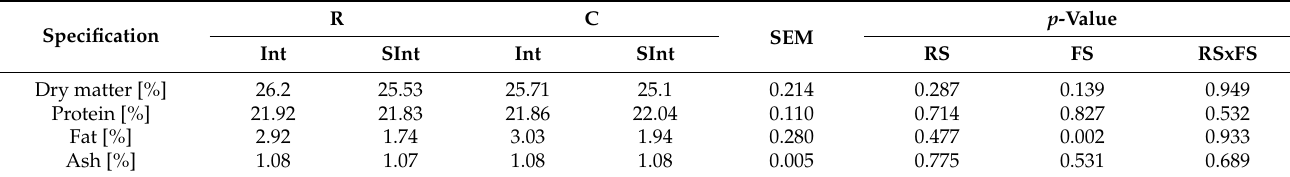
Table 1. The proximate composition of the longissimus lumborum